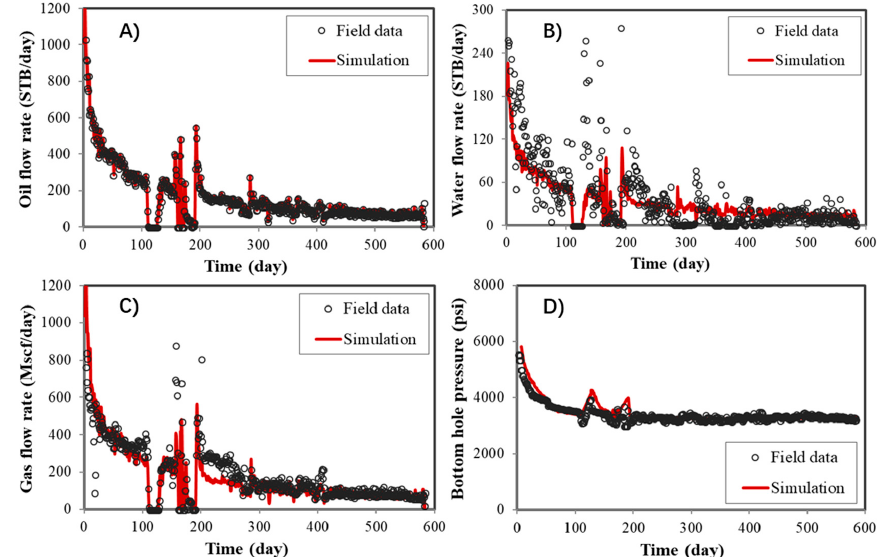
Figure 5. Results of history matching. ( a ) Oil flow rate; ( b )Water flow rate; ( c ) Gas flow rate; ( d ) Bottom hole pressure.